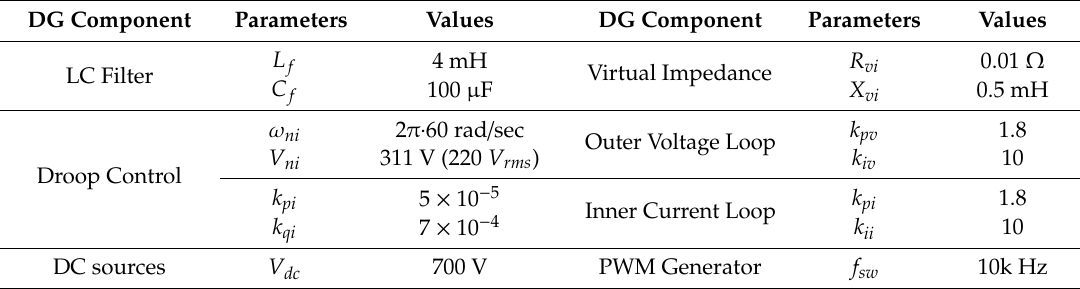
Table 2. Parameters of DG unit components and primary control.